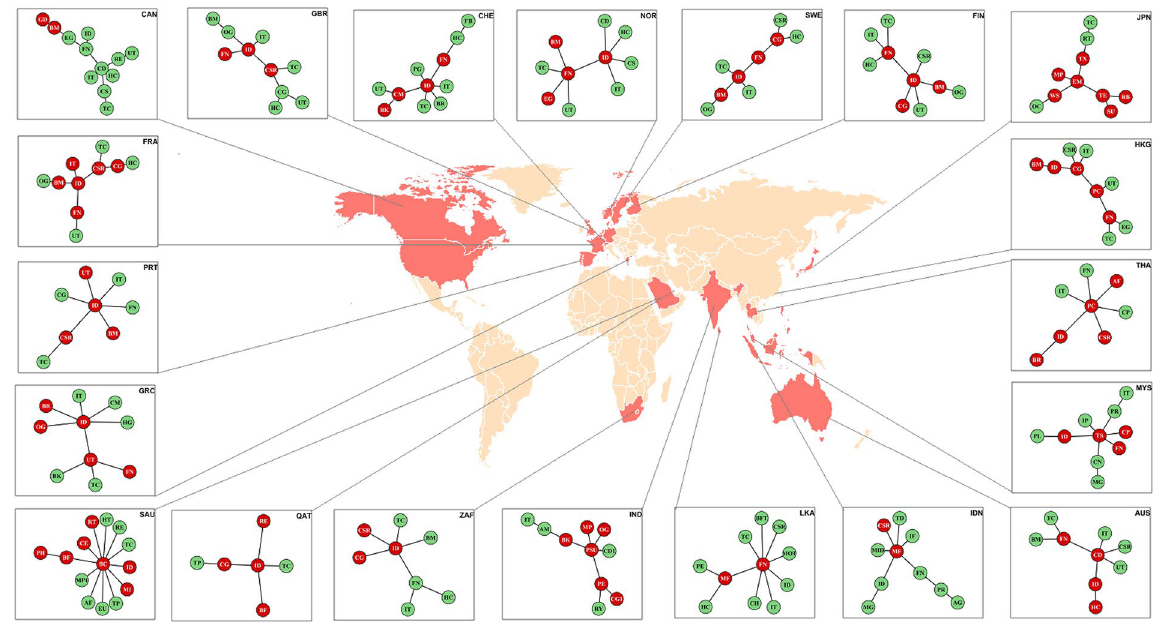
Figure 2. Minimum spanning trees for 20 countries out of the 27 countries (shown in peach) that are being studied across the globe. The core sectors are colored red (darker shade), while the sectors in the periphery are in pale green (lighter shade); sectoral abbreviations given in the Table 1 in Sec. Materials and Methods. The world map has been generated with the open source software R-Statistical Computing and Graphics (version